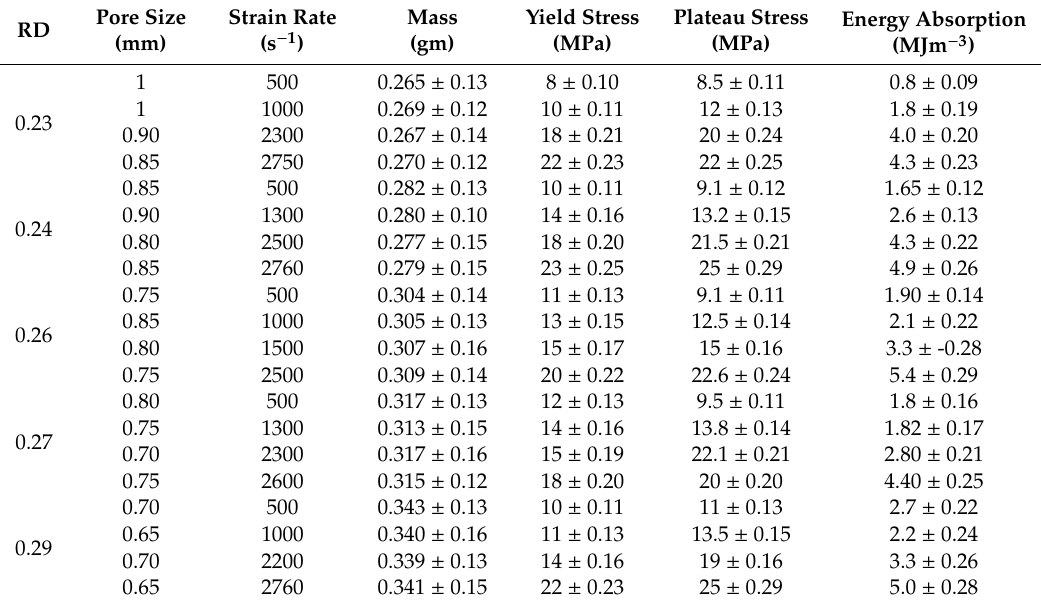
Figure 5. ( a ) compressive stress–strain diagram of Al hybrid composite foam with RD = 0.29 at di ff erent Table 1. Relative density, plateau stress, yield stress, energy absorption of Al composite hybrid foam with graphene at various strain rates and input data for